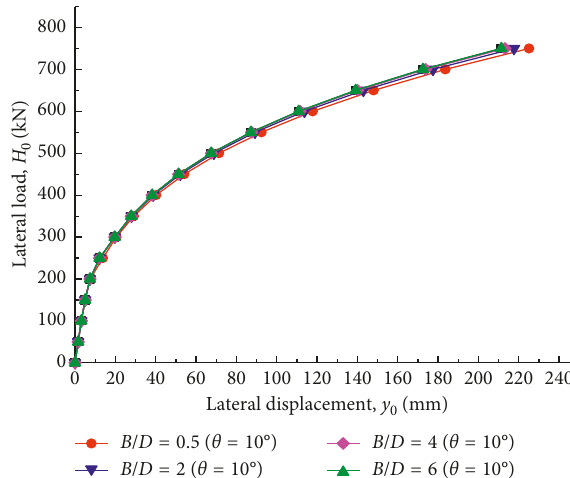
Figure 13: Depth of fixity variation with different slope angle.